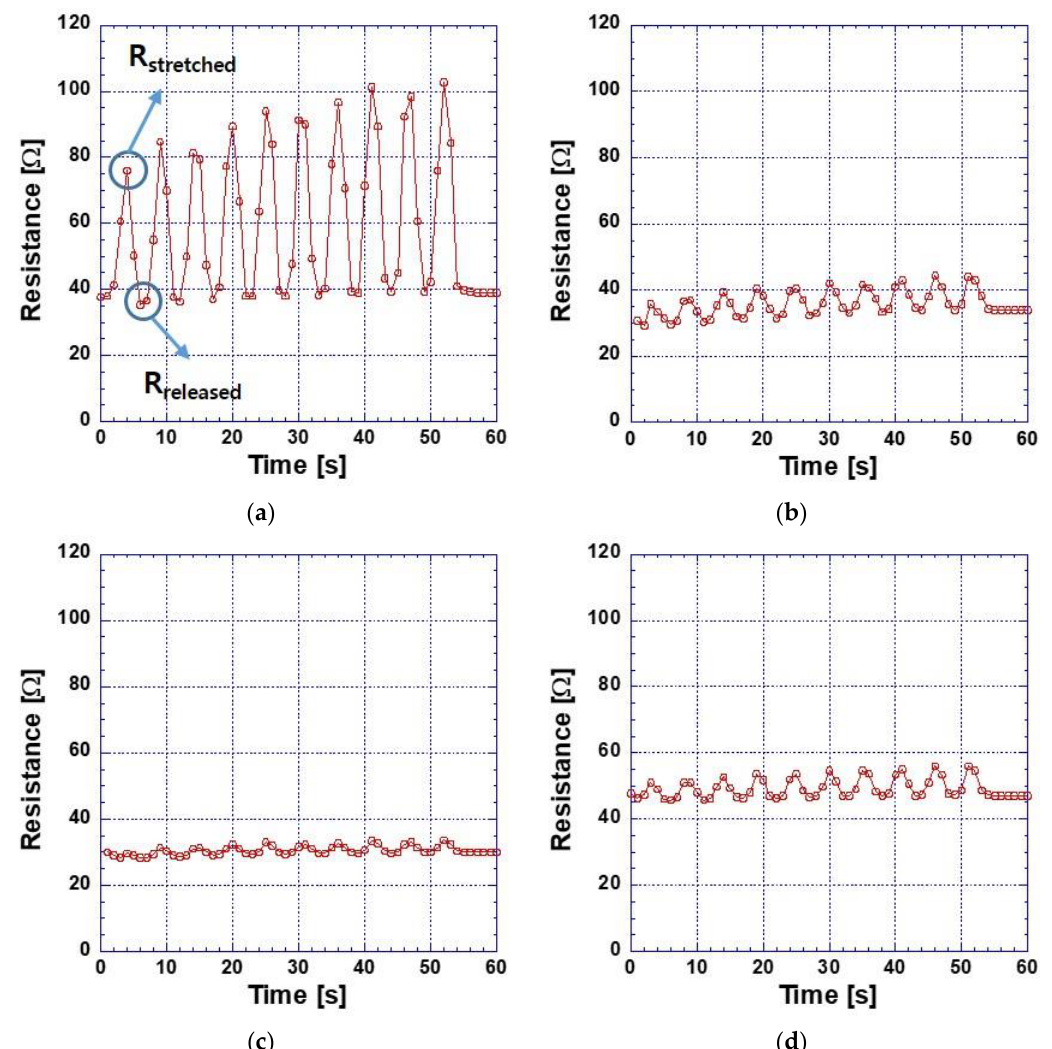
Figure 2. In situ resistance change of Ag NWs electrode on variously pre-stretched silicone rubber film during a cyclic test with 10 times repetition applying 10% strain: ( a ) 10% pre-stretched; ( b ) 20% pre-stretched; ( c ) 30% pre-stretched; and ( d ) 40% pre-stretched.